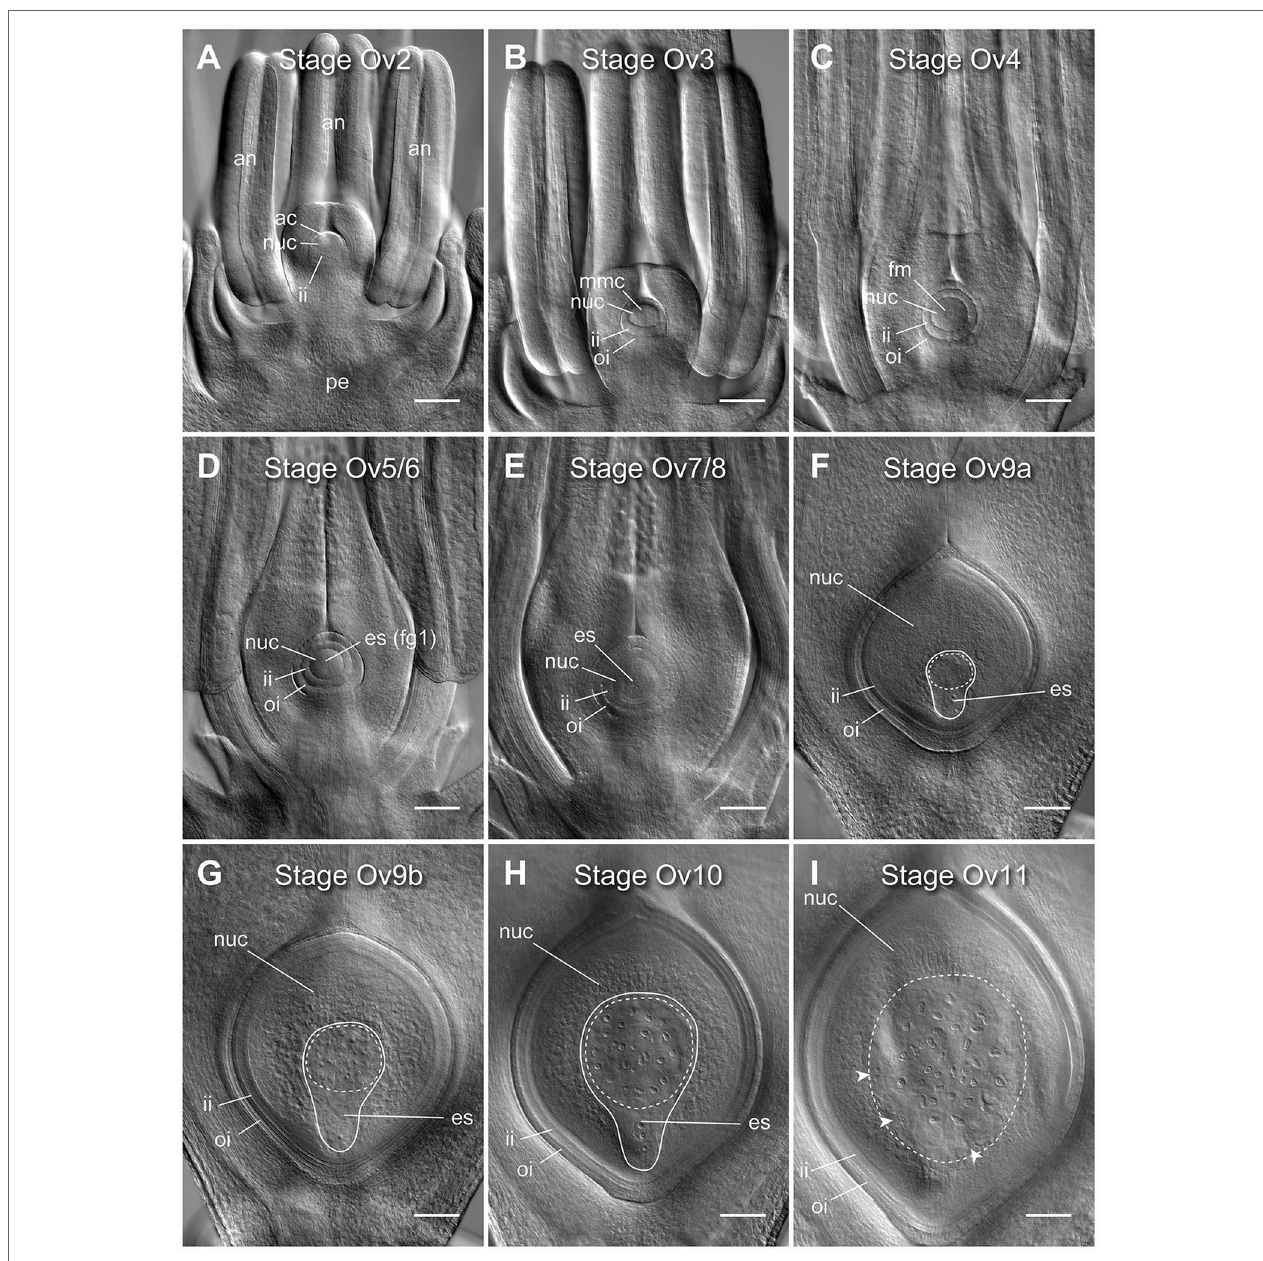
FIGURe 1 | Clearing of whole barley florets and pistils reveals different stages of ovule development. (a) At stage Ov2 the ovule has initiated in the center of the carpel and is characterized by the selection of an archesporial cell and initiation of the inner integument. (B) At stage Ov3 the megaspore mother cell (MMC) has differentiated from the archesporial cell and both integuments are observed. (C) At stage Ov4 the MMC has undergone meiosis, giving rise to four haploid daughter cells. The nucellar dome is obvious between the two growing integuments. (D) At stage Ov5/6 the functional megaspore has been selected and possibly initiated mitosis to form the embryo sac (ES), while the nucellar dome is not fully enclosed. (e) At stage Ov7/8 the integument has closed over the nucellus thus forming the micropyle. During this stage, the embryo sac will complete mitotic divisions and cellularize, producing two synergid cells, an egg cell, a central cell with two polar nuclei, and at least three antipodal cells. (F) At stage Ov9a growth of the ovule has increased rapidly, and the antipodal cells proliferate to become a group of 15 to 45 small and tightly clustered cells. (G) At stage Ov9b growth of the ovule has begun to slow, and the antipodal cells are distinctly less tightly clustered. (h) At stage Ov10 the ovule reaches anthesis, or reproductive maturity, discernible from stage 9b by slightly larger nucellus and embryo sac areas, and greater spacing of the antipodal cell nuclei. (I) At stage Ov11 the ovule is fertilized, as determined by a combination of a large increase in ovule size, visibility of sperm nuclei, lack of visibility of the polar nuclei, irregular shapes of antipodal cells, and clusters of small nuclei at the periphery of the embryo sac. ac, archesporial cell; es, embryo sac; fg1, one- cell female gametophyte; fm, functional megaspore; ii, inner integument; mmc, megaspore mother cell; oi, outer integument; nuc, nucellus. A solid line indicates the bounds of the embryo sac, a dashed line indicates the bounds of the antipodal cell cluster, arrowheads indicate additional clusters of nuclei after fertilization. Images from the genotype Salka. Scale bars = 100 µm.